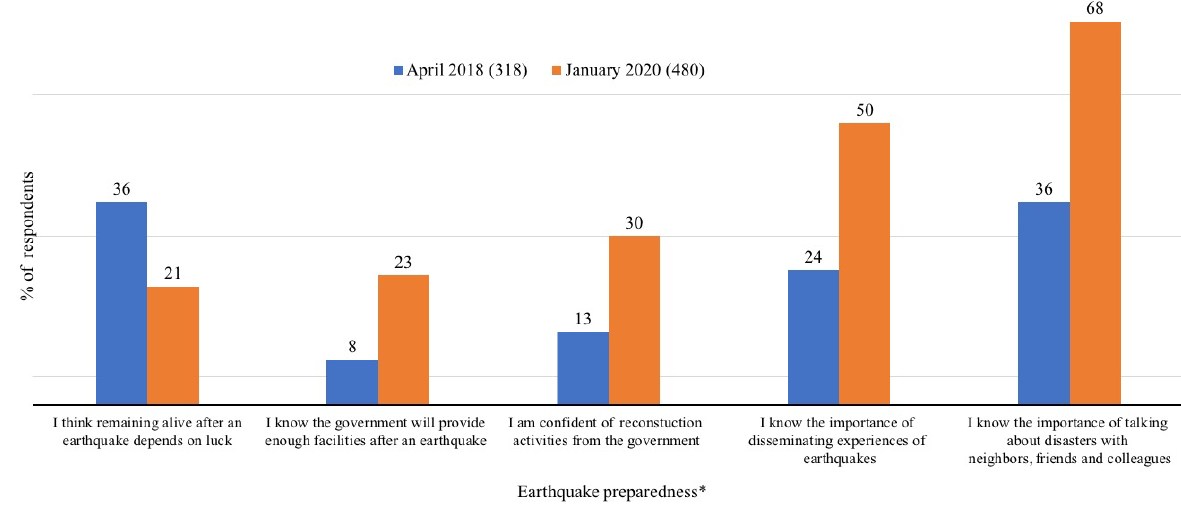
Figure 9. Students’ own opinions on earthquake preparedness (Q14), before and after the initiation of our education program. Note: ∗ – Multiple answers were possible.